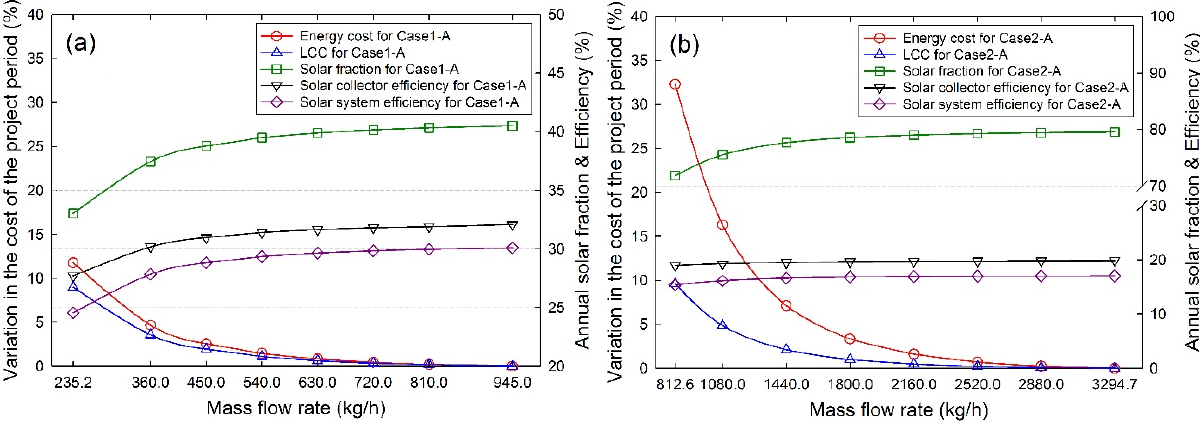
Figure 11. Effect of mass flow rate on the cold side of the heat exchanger on the energy and economic performances of the SWH systems: ( a ) Case1-A and ( b ) Case2-A.